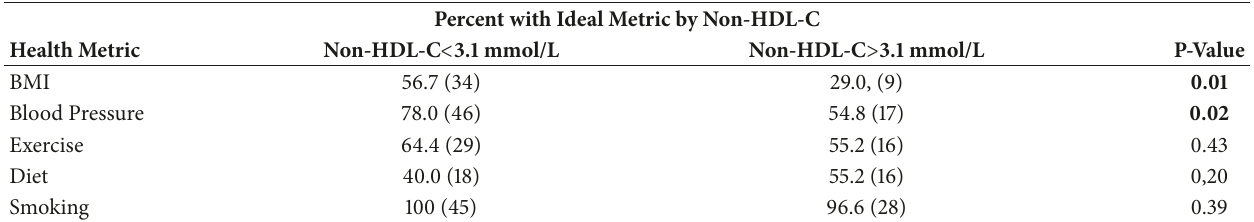
Table 2: Percent of participants who achieved an ideal metric for BMI, blood pressure, exercise, diet, and smoking by non-HDL-C below and above the 3.1 mmol/L (120 mg/dL) cut point and p values for differences (Chi-square